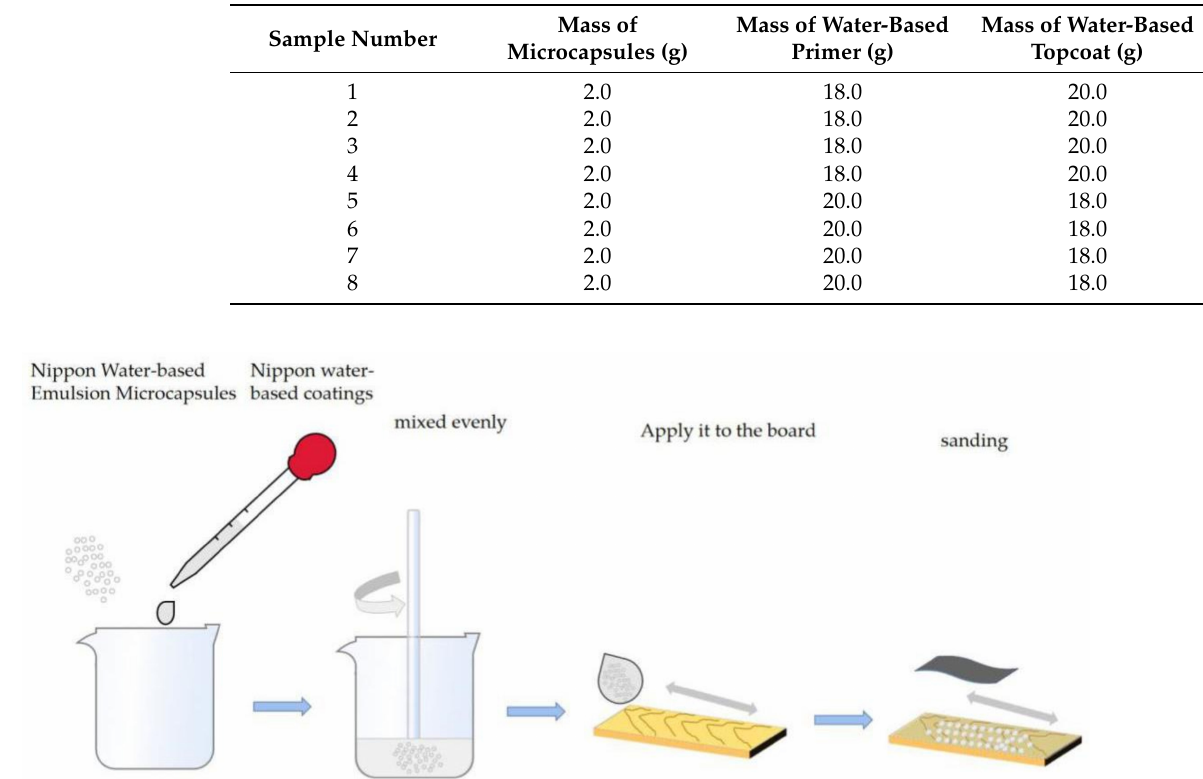
Table 3. Components of the water-based coatings with microcapsules.